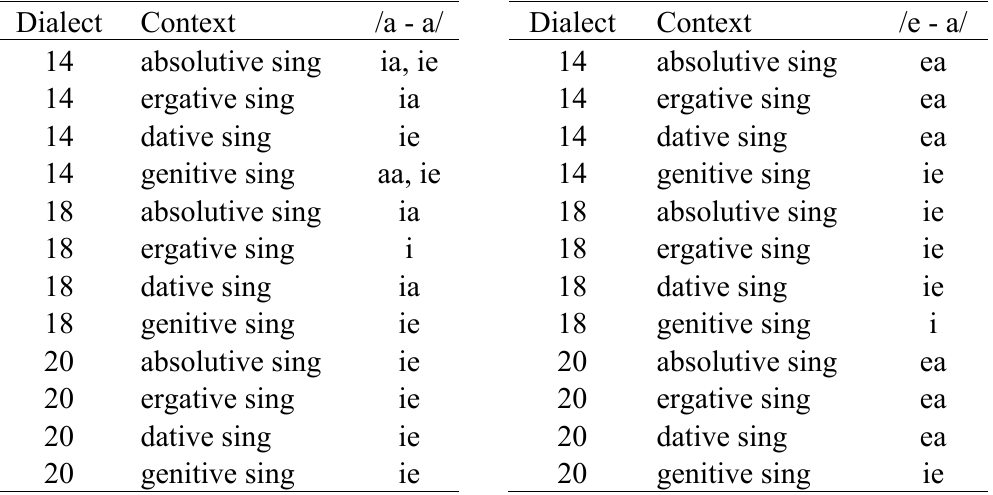
Table 9 . Interaction between the last vowel of a-final stems (left) and e-final stems (right) and the first vowel of four a-initial suffixes, as attested in three